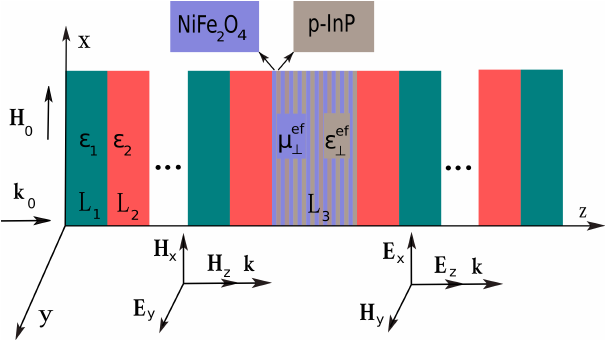
Figure 1. Sketch of the symmetrical microcavities